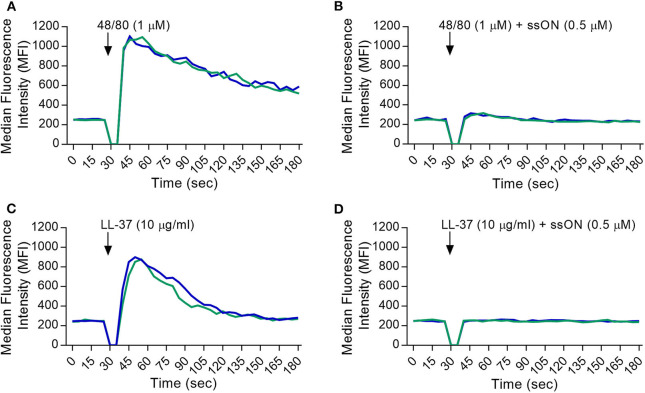
ssON inhibited the activation of MRGPRX2 by C48/80 and LL-37. A stably MRGPRX2-transfected HEK293 cell line was used. Intracellular calcium (Ca2+) influx was determined by loading cells with Fluo-3 dye and measuring the median fluorescence intensity (MFI) during treatment. MFI curves were recorded for 30 s (sec) to obtain a baseline. The cells were then stimulated during the gap in the analysis with (A,B) C48/80 or (C,D) LL-37 with and without ssON, and further recorded for 2.5 min. The Ca2+ influx induced by the activation of MRGPRX2 with C48/80 and LL-37 was completely blocked by ssON. Each curve represents an independent sample. Gaussian smoothing is applied. Three independent experiments were performed in duplicate. A representative result is shown.